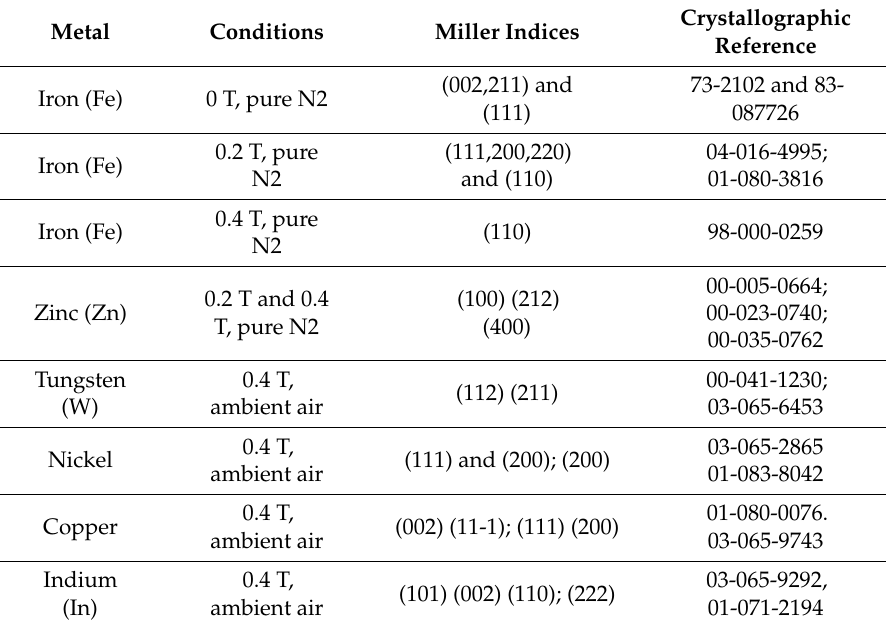
Table 2. Comparation of Miller indices of di ff erent metal wires used as sparking material, as published